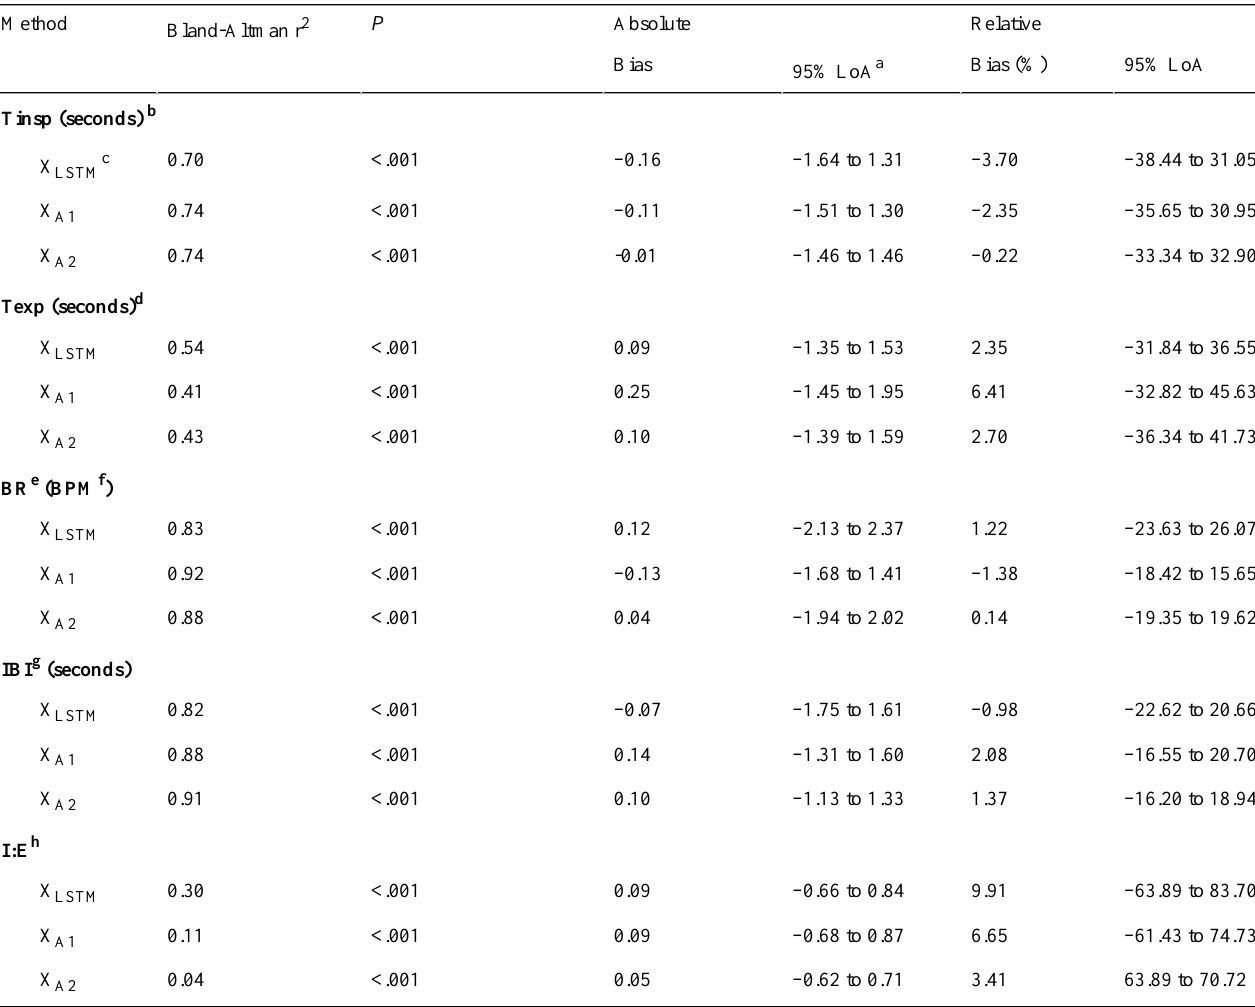
Table 4. Derived breathing metrics using the X LSTM , X A1 , and X A2 methods and associated statistical analyses.